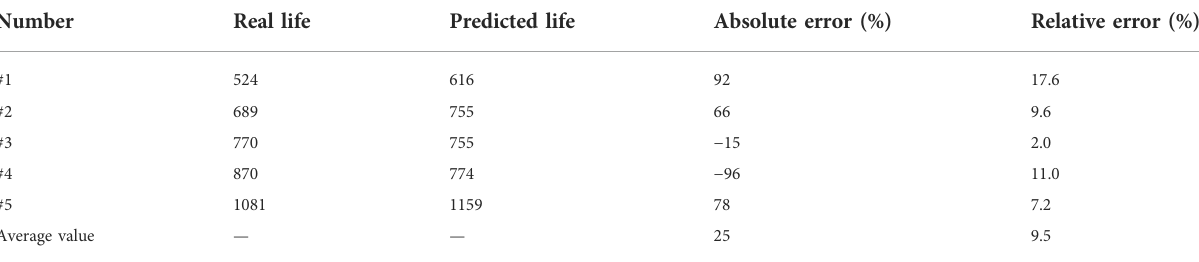
TABLE 2 Life prediction results of different